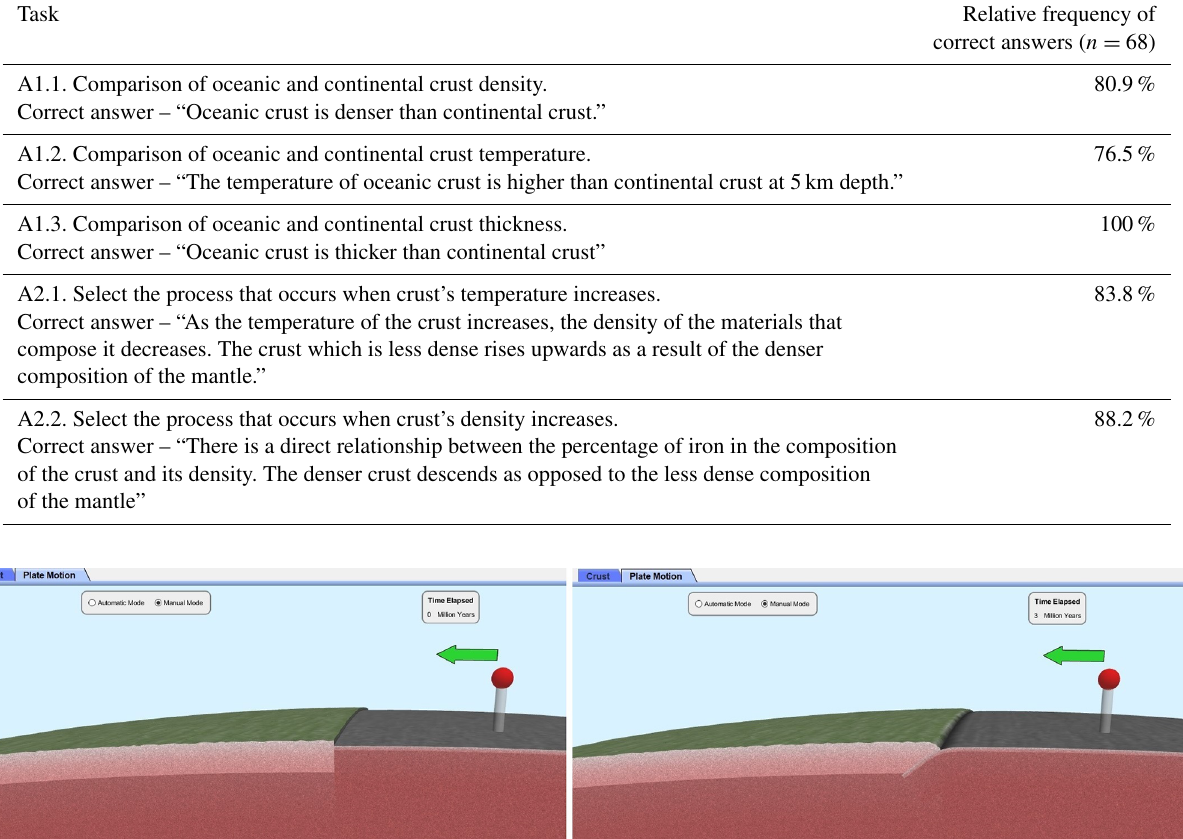
Table 2. Results of pre-service teachers’ tasks A1.1. to A2.2.